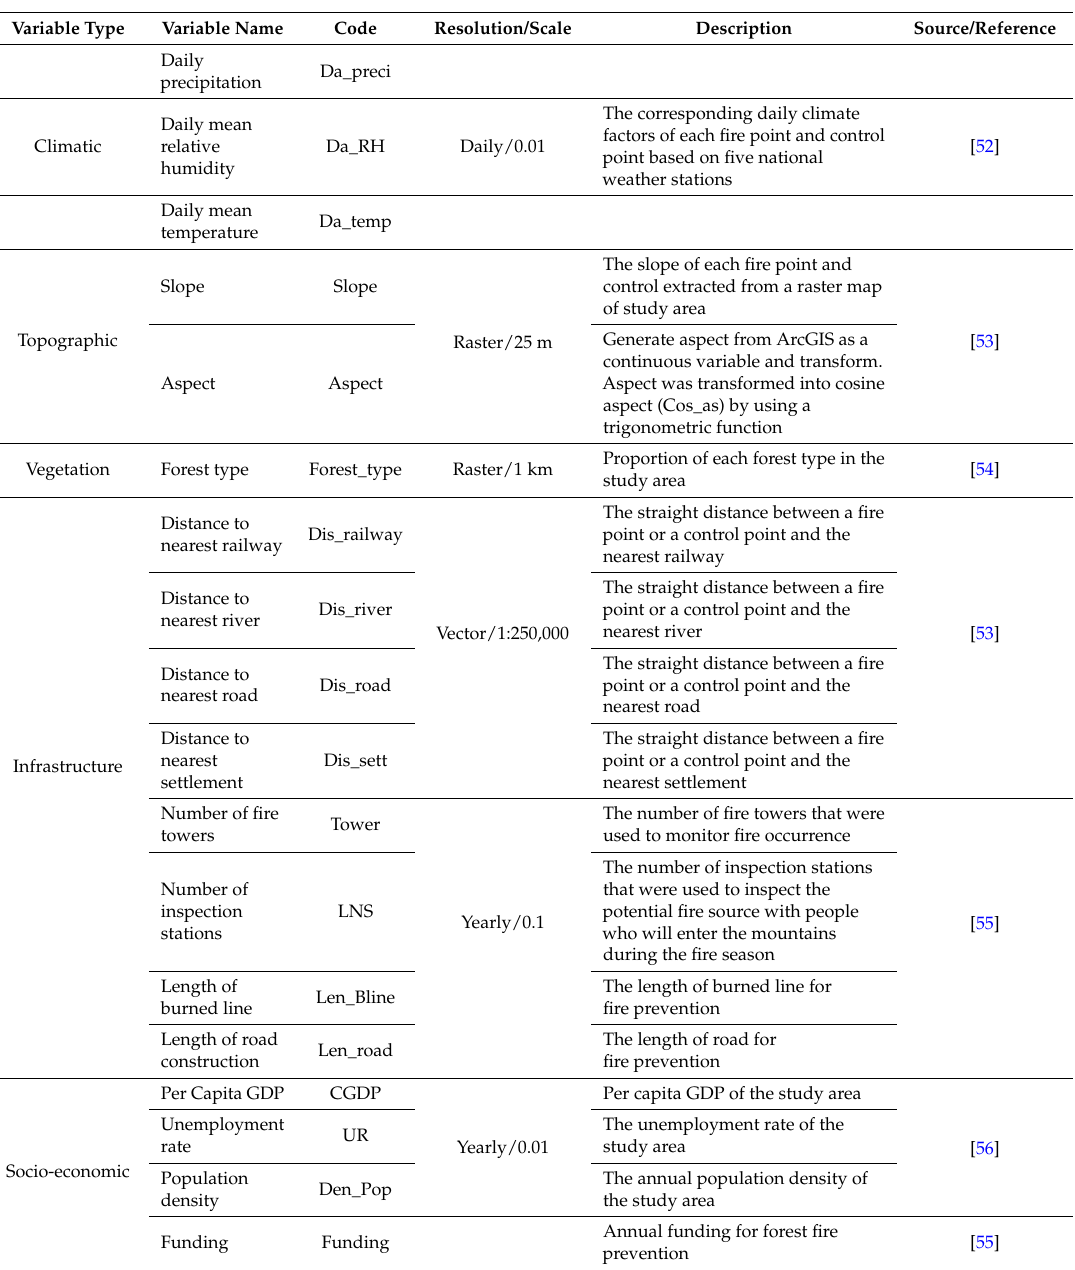
Table 1. Independent or predictor variables included in forest fire model development for Daxing’an